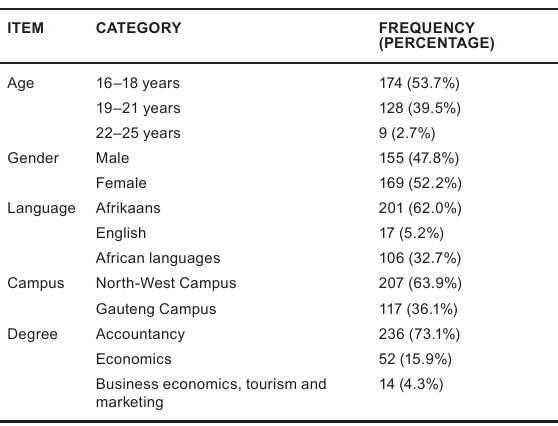
table 3 Characteristics of the population (n =